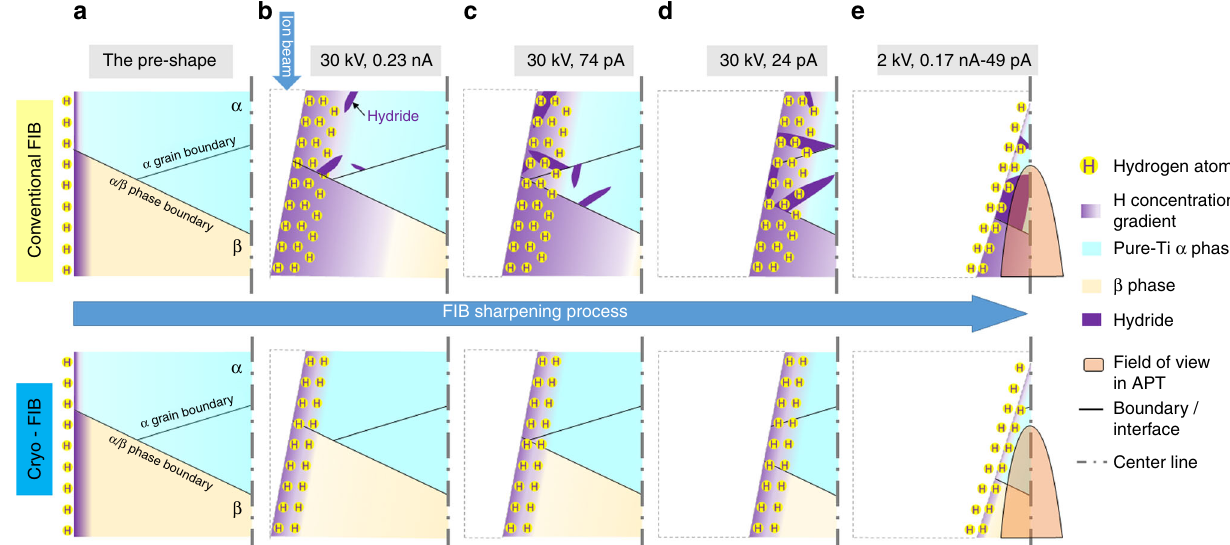
Fig. 5 Schematic summary: Schematic of H pick-up during focussed ion beam (FIB) sharpening of an atom probe tomography (APT) specimen at room temperature (top) and at cryogenic temperature (bottom). a H atoms from environment are adsorbed on the sample surface. b – d When applying ion beam milling, H atoms on the surface are implanted by the ion beam. At room temperature, H would then diffuse deep into specimen, and hydrides probably form and grow during milling process in case of pure Ti α phase (hydride formation is likely inhibited by Al addition in α phase 25,35 ). At cryogenic temperature, the beam damage and H implantation are slightly reduced and H diffusion is signi fi cantly suppressed. e Final cleaning at low kV removes the surface damage layer and leaves only a thin layer of H implantation, which is in any case outside the fi eld of view during APT